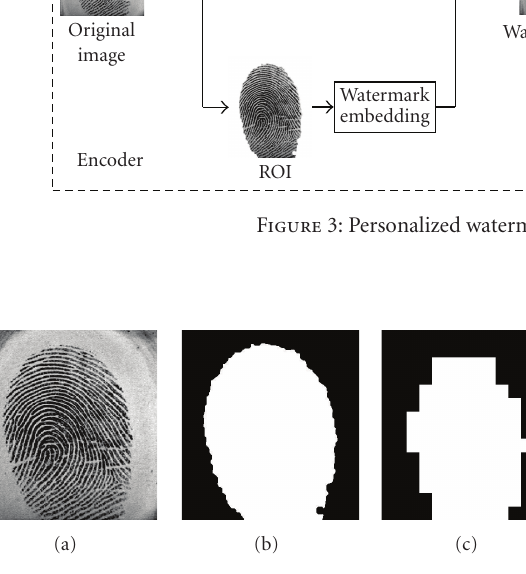
Figure 4: Example of fingerprint image: (a) original image, (b) region mask, (c) watermarking mask. The block size =